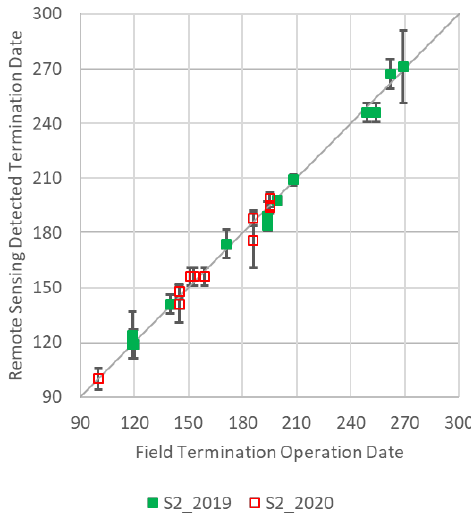
Figure 10. Scatter plot of the detected termination dates for fields at the BARC in 2019–2020 using the Sentinel-2 NDVI time-series and the recorded harvest operation dates. The vertical bar shows the uncertainty of the estimated termination date.